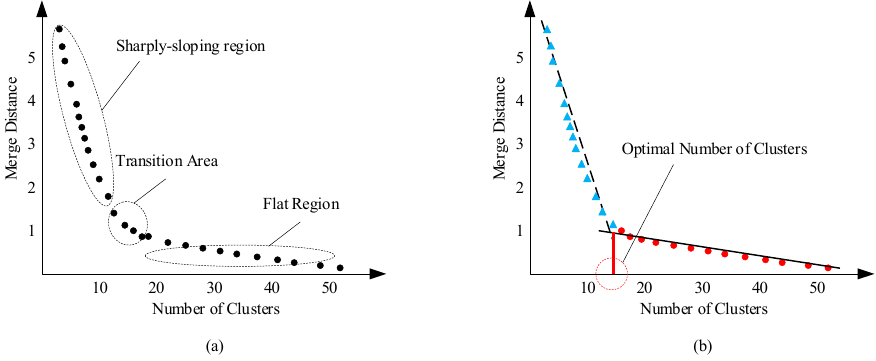
Figure 3. ( a ) A sample evaluation graph; ( b ) finding the number of clusters using L method. The problem shifts to finding some point in the asymptotic region (i.e., the best clustering number c), noting that the asymptotic region is between 2 linear regions and that the slope of the tangent at that point is mutated, so it is only necessary to find some point in the asymptotic region and use that point as a boundary to perform a linear fit to the data points in the steep and straight region on the left and the data points in the flat region, and the optimal clustering number is obtained when the fit to the data points in both regions is best at the same time. Now define a metric that captures the interpolated mean of